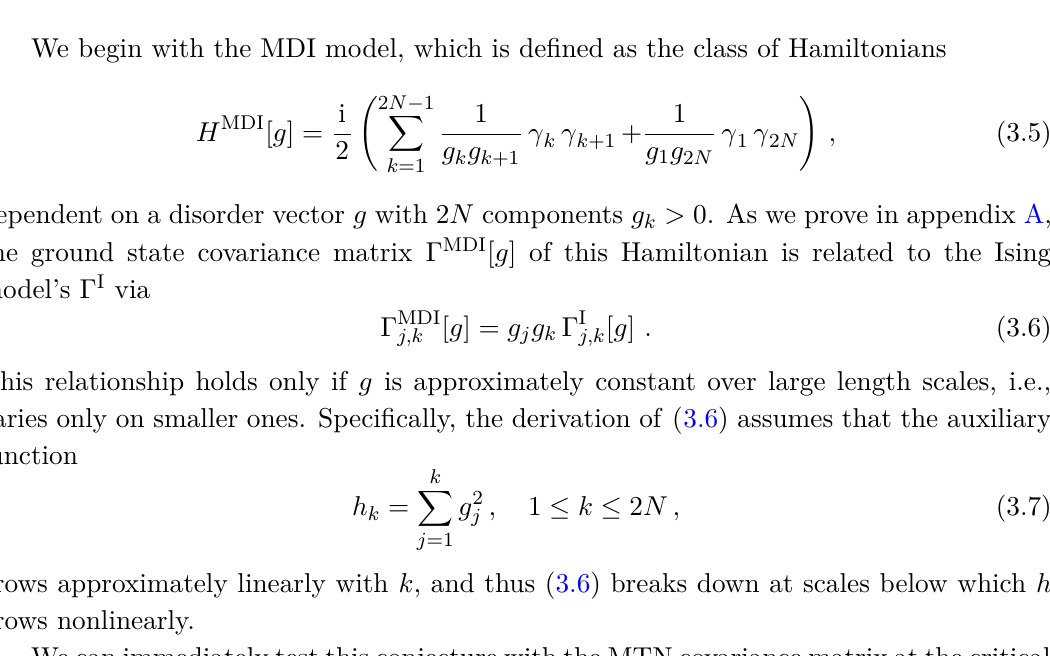
Figure 4 . The space of theoretical models considered in this paper. All are based on exactly solvable Gaussian fermionic models (describable by a Hamiltonian (A.1)) with correlation functions that are fully encoded by a covariance matrix. Only a subset of Gaussian models are translation- invariant, in particular including the (critical) Ising model. This model is generalized into the mode-disordered Ising (MDI) model described by a Hamiltonian (3.5), with the critical Ising model resulting from a trivial (constant) disorder vector. The MDI model includes the multi-scale qua- sicrystal Ising (MQI) model where the disorder vector is specified by a multi-scale quasicrystal ansatz (MQA) as introduced in section 3.2. Instances of the MQI model with symmetries of regular tiling layers closely approximate the { 3 , 7 } and { 4 , 5 } matchgate tensor network (MTN) states at their critical Ising point, the latter being discussed in appendix